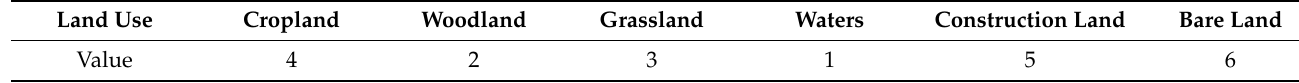
Table 2. Land use Assignment in